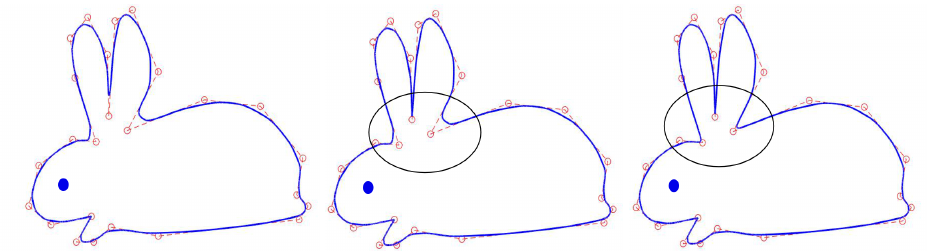
Figure 8. Close curves with uniform knot vector of the shape functions with α i ( t ) and β i ( t ) given in Equation (13).